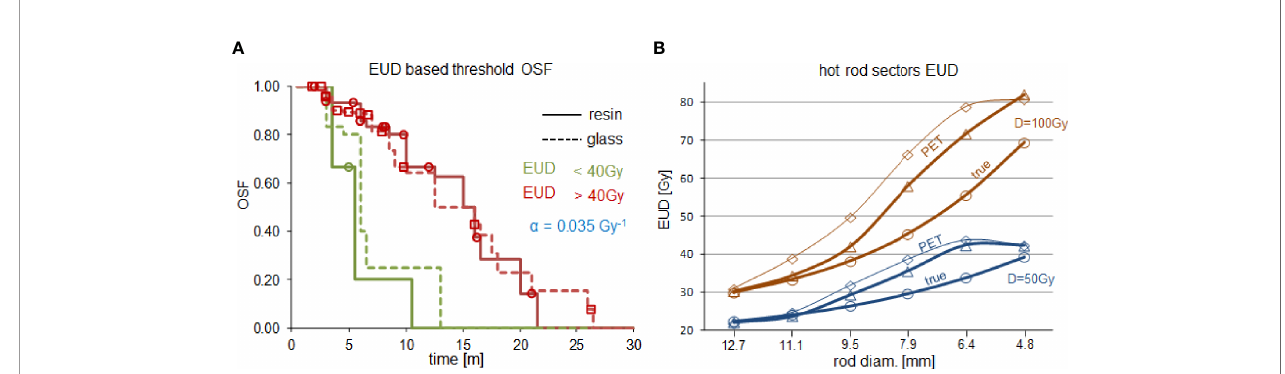
FIGURE 3 | (A) Overall survival fraction (OSF) in HCC liver radioembolizations with resin spheres (solid line) and glass spheres (dashed line) using the same 40Gy- dose threshold on the 550ps TOF-PET based EUD: a =0.035Gy -1 (reprinted from (34) with permission of IOP publishing). (B) comparison of the 550ps TOF-PET based sectors EUD: a =0.035Gy -1 (triangles, diamonds are without and with 6mm-FWHM fi ltering, respectively) with the true sectors EUD: a =0.021Gy -1 (circles) for a mean sector dose D of 50Gy (blue) and